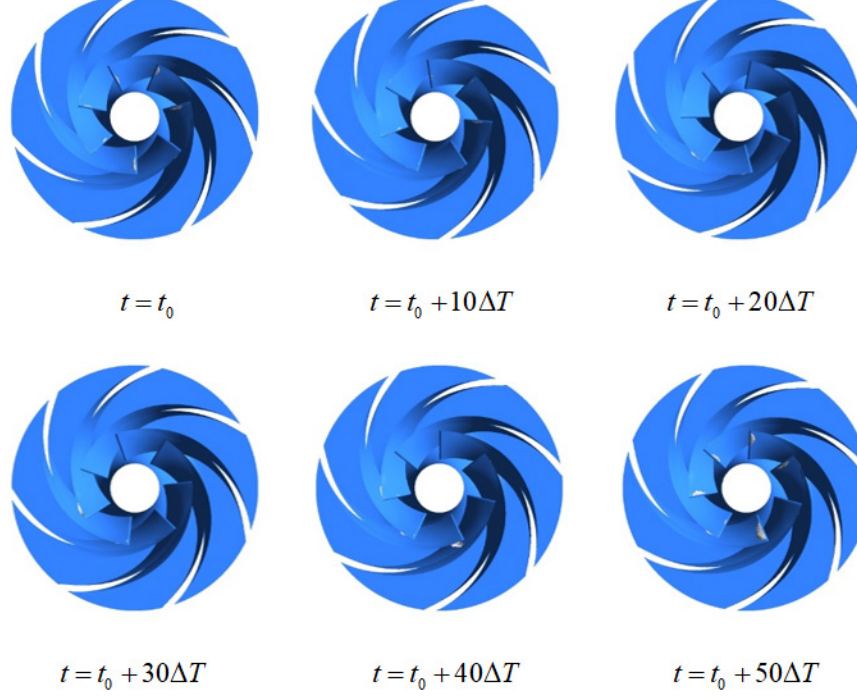
Figure 8. Bubble distribution at the impeller inlet ( NPSH a = 7 m).